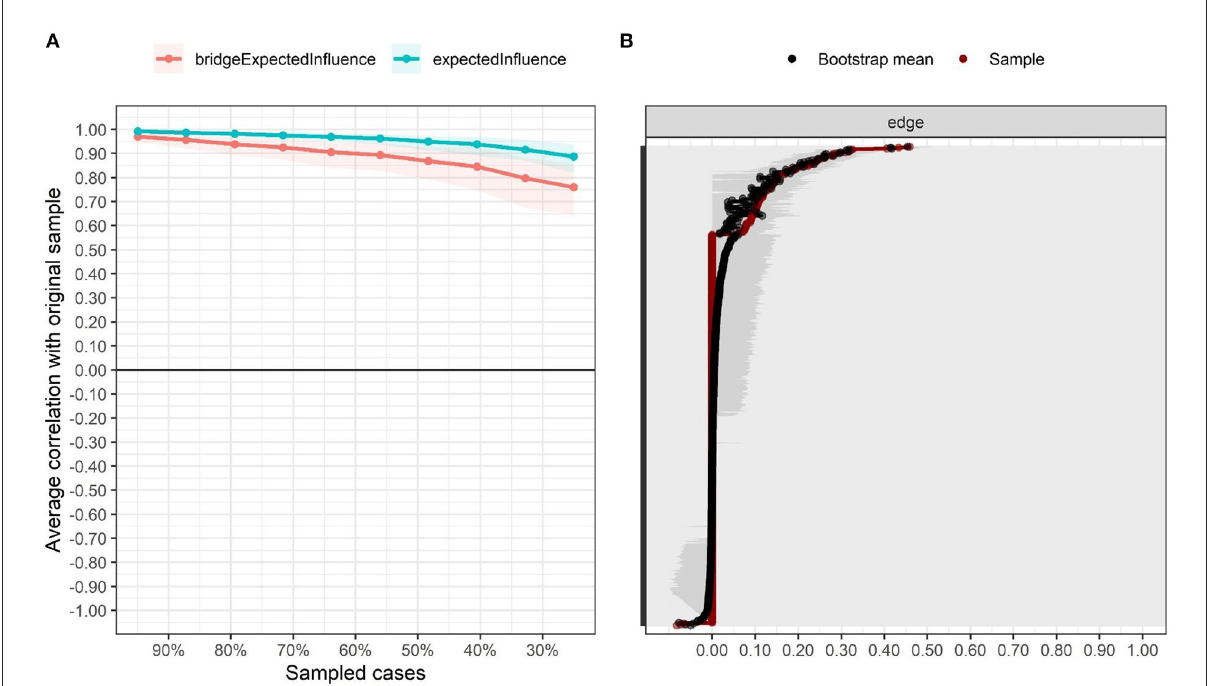
FIGURE2 Stability and precision of the estimated network. (A) Stability of centrality indices, (B) Precision of network edges.